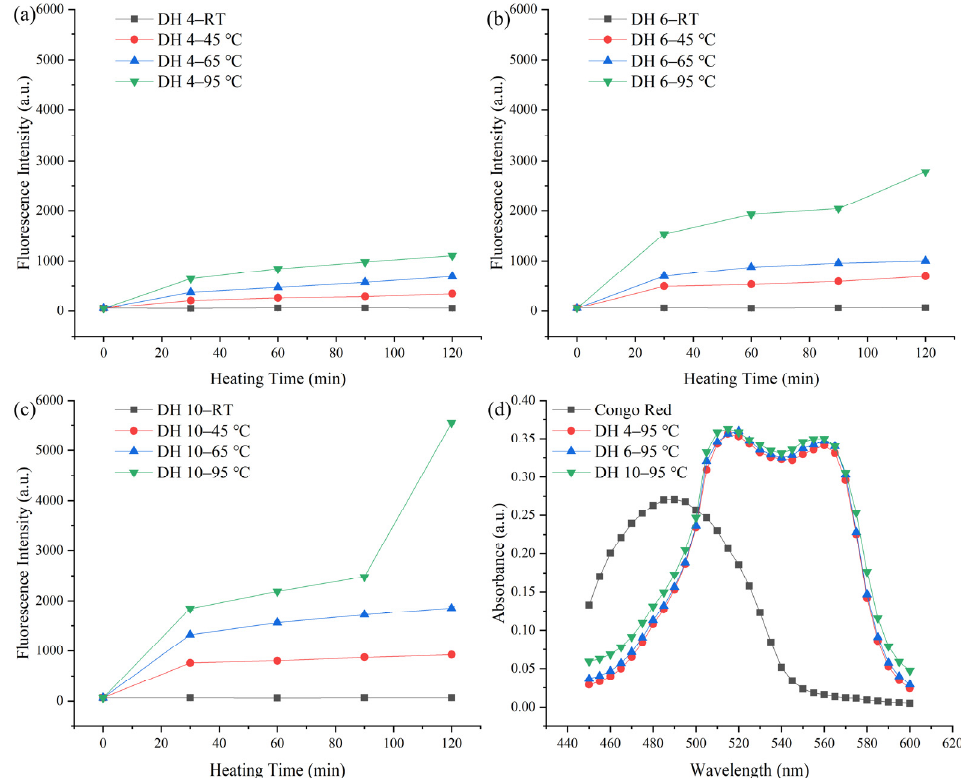
Figure 1. ThT fluorescence intensity of the degree of hydrolysis (DH) 4.0% ( a ), DH 6.0% ( b ), and DH 10.0% ( c ) GPs during heating. Congo red spectrum ( d ). RT, 45, 65, and 95 represent the room temperature, 45 °C, 65 °C, and 95 °C, respectively.